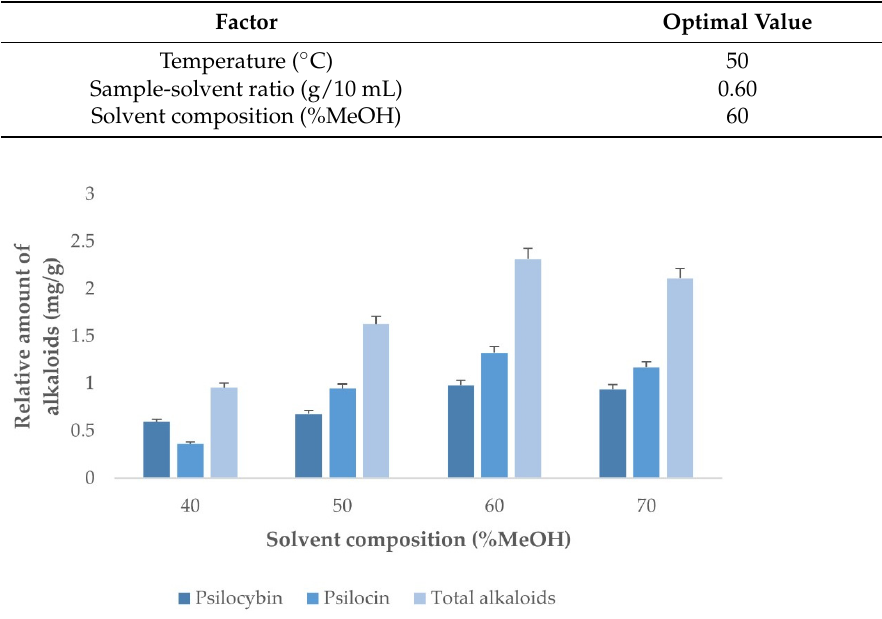
Table 3. Optimal extraction conditions.